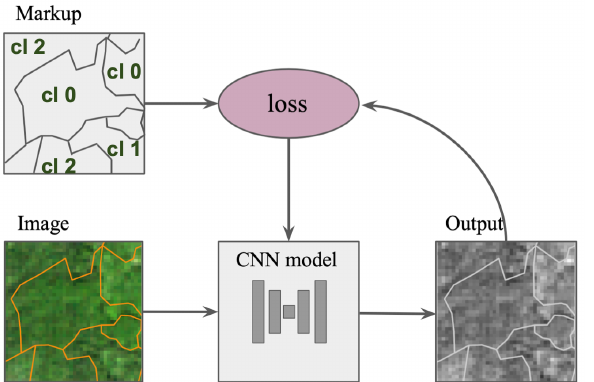
Figure 7. The commonly used per-pixel semantic segmentation approach. The model produces the map where the probability of a class is recorded at each pixel. Loss is computed for the entire patch. The patch includes stands with different dominant species (class 0, class 1, etc.).